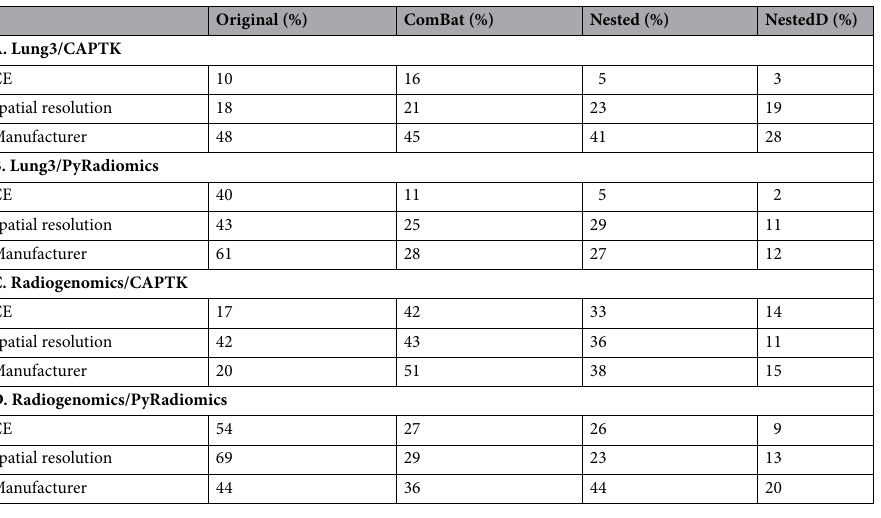
Table 1. (A) Percentage of features with significantly different distributions attributable to contrast enhancement, spatial resolution due to reconstruction kernel, and manufacturer in the original features and after applying standard ComBat, Nested ComBat, and NestedD (dropping with every iteration) ComBat in the CapTK features extracted from the Lung3 dataset. (B) Corresponding table for PyRadiomics features extracted from the Lung3 data. (C) Corresponding table for CapTK features extracted from the Radiogenomics dataset. (D) Corresponding table for PyRadiomics features extracted from the Radiogenomics dataset. Tables contain the percentage of features out of the original number of features with detected significant ( p < 0.05) differences in distribution for all batch